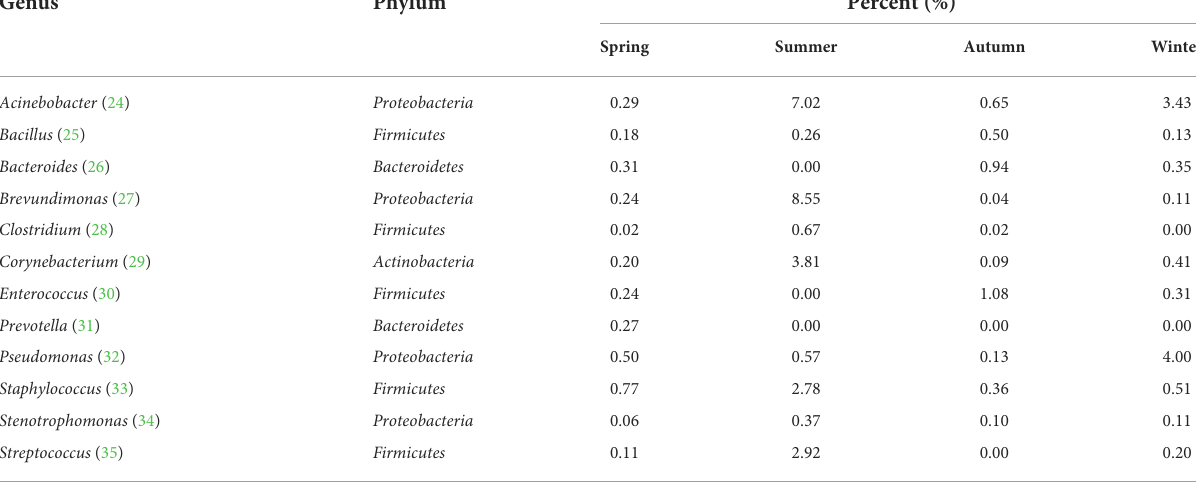
TABLE 1 Distribution characteristics of potential animal pathogens in air samples from the broiler house.